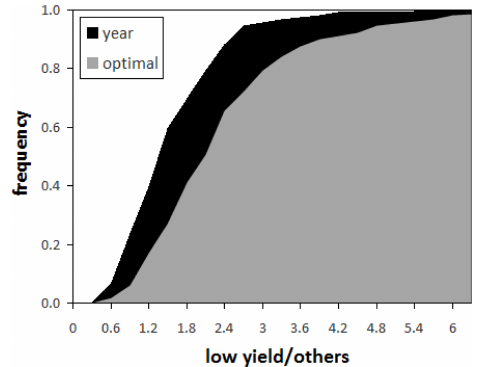
Figure 10. Cumulated frequency of (i) the ratio between the number of fAPAR anomalies < − 1 in the optimal period (see Sect. 3.3) dur- ing low-yield years (yield anomalies < − 1) and other years (yield anomalies ≥ − 1) (optimal, grey area) and (ii) the ratio between the number of fAPAR anomalies < − 1 in the full year (36 dekads) dur- ing low-yield years and other years (year, black